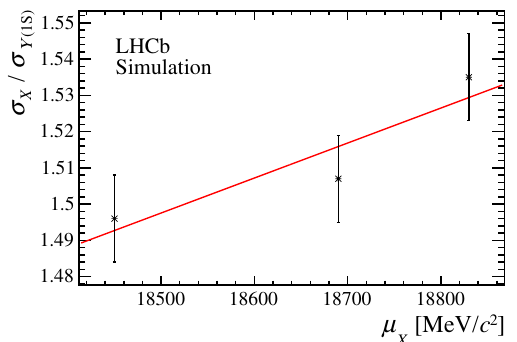
Figure 1 . Linear (cid:12)t to the ratio of the X and (cid:7) (1 S ) widths as a function of the X mass as determined from (cid:12)ts to simulated data samples. The error bars represent the statistical uncertainty arising from the (cid:12)nite size of the simulated